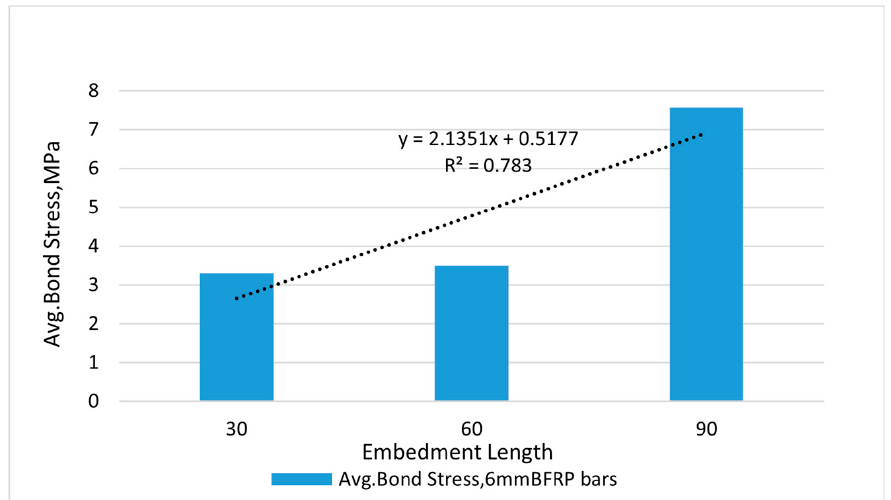
Figure 9 . Average bond stress of 6-mm BFRP bars vs. embedment length .